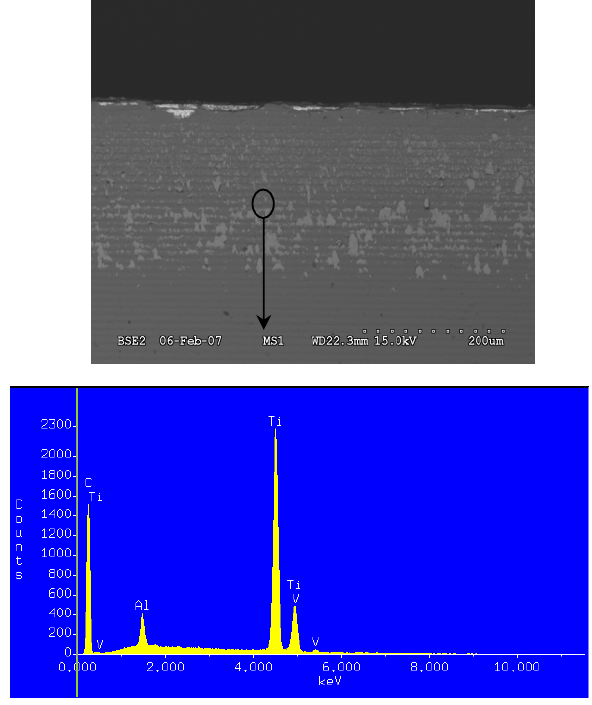
Figure 20. Energy X-ray spectrometer (EDS) measurements of the adhered material (Ti-6Al-4V) on the rake face. V = 20 m/min, rake angle 0°.